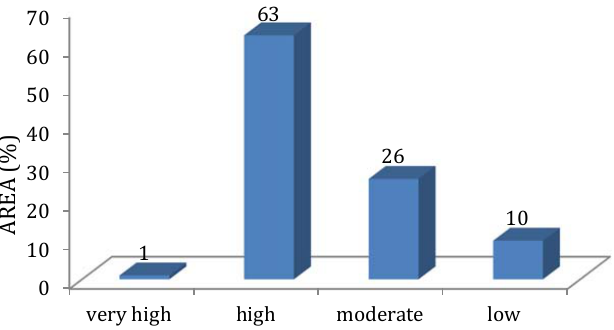
Figure 9. Distribution of suitable areas in the Kabul aquifer.